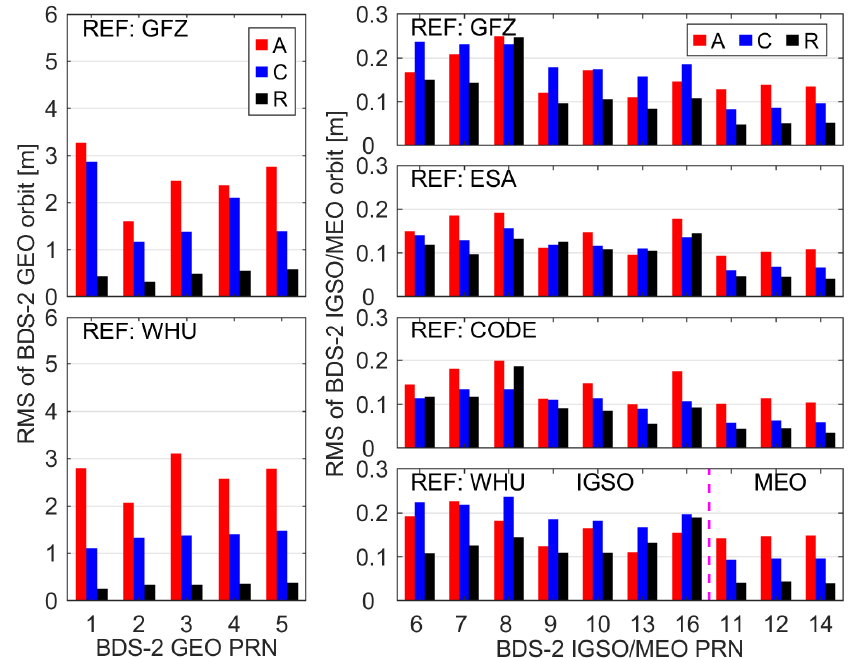
Figure 6. RMS of BDS-2 ISR orbits based on B1I/B3I compared with different MGEX ACs in the along-track (A), cross-track (C), and radial (R) directions, respectively. To comprehensively assess the difference between ISR B1I/B3I-based and B1C/B2a- based orbit products, Figure 7 shows the comparison results of ISR with four MGEX